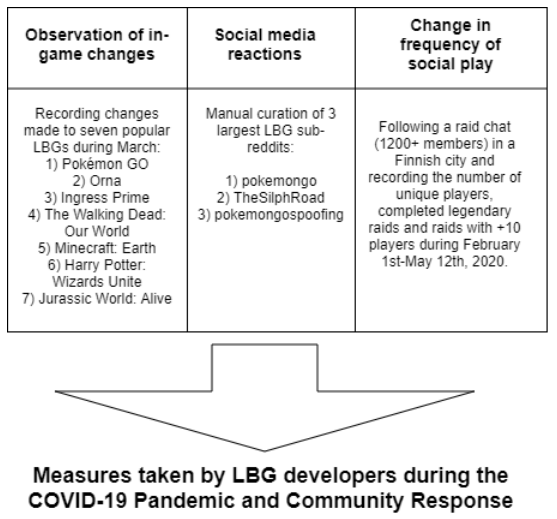
Figure 1. The research methodology